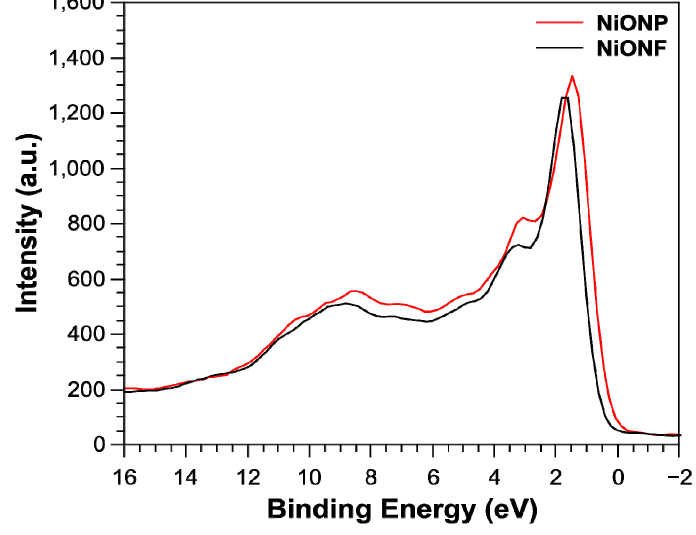
Figure 5. Ni valence spectra for NiO nanofibers and